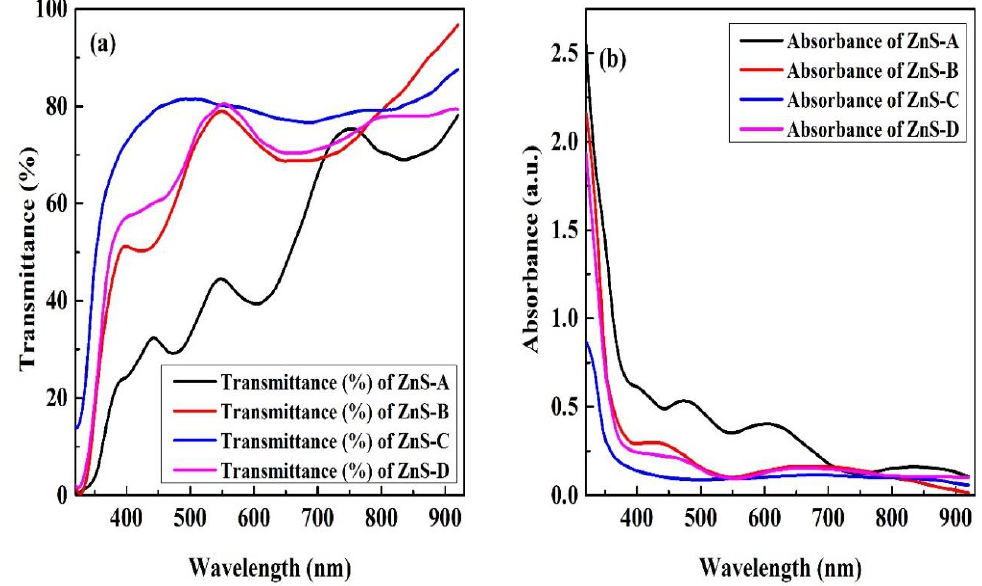
Figure 4. ( a ) Optical transmittance and ( b ) absorbance of deposited ZnS thin films. The optical band gaps of all deposited samples were measured by Tauc’s relation- ship. The extrapolating of the linear portion of h υ versus ( αh υ ) 2 curve provided the optical band gap of samples [58].